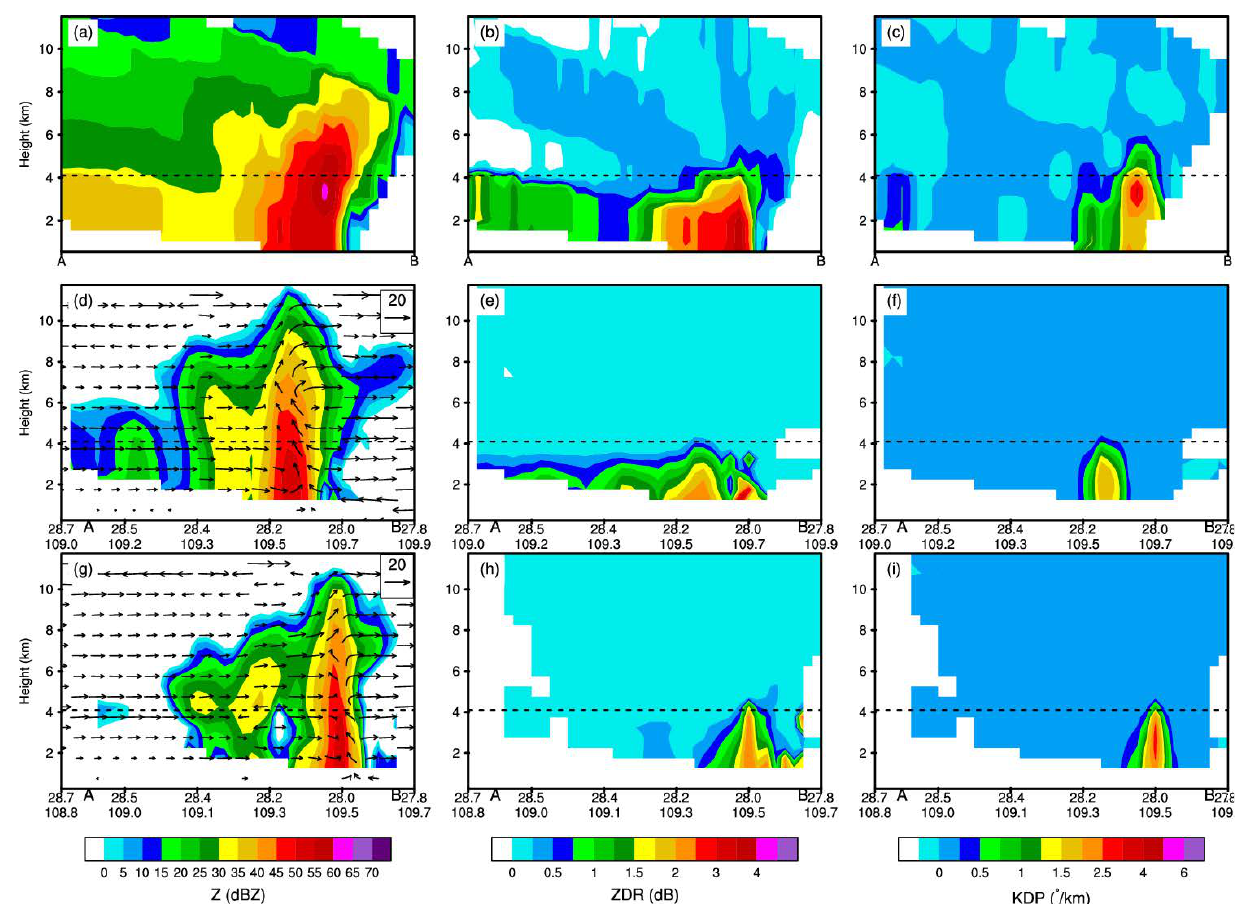
Figure 9. Cross section of ( a , d , g ) radar reflectivity ( Z ; dBZ), ( b , e , h ) differential reflectivity ( Z DR ; dB), and ( c , f , i ) K DP ( ◦ /km) from the ( a – c ) S-POL radar and ( d – f ) MORR and ( g – i ) WDM6 microphysics schemes. The dashed black line indicates the freezing level and the black arrows represent wind (m/s). The black lines in Figure 7 a,d,g indicate the locations of the cross-section